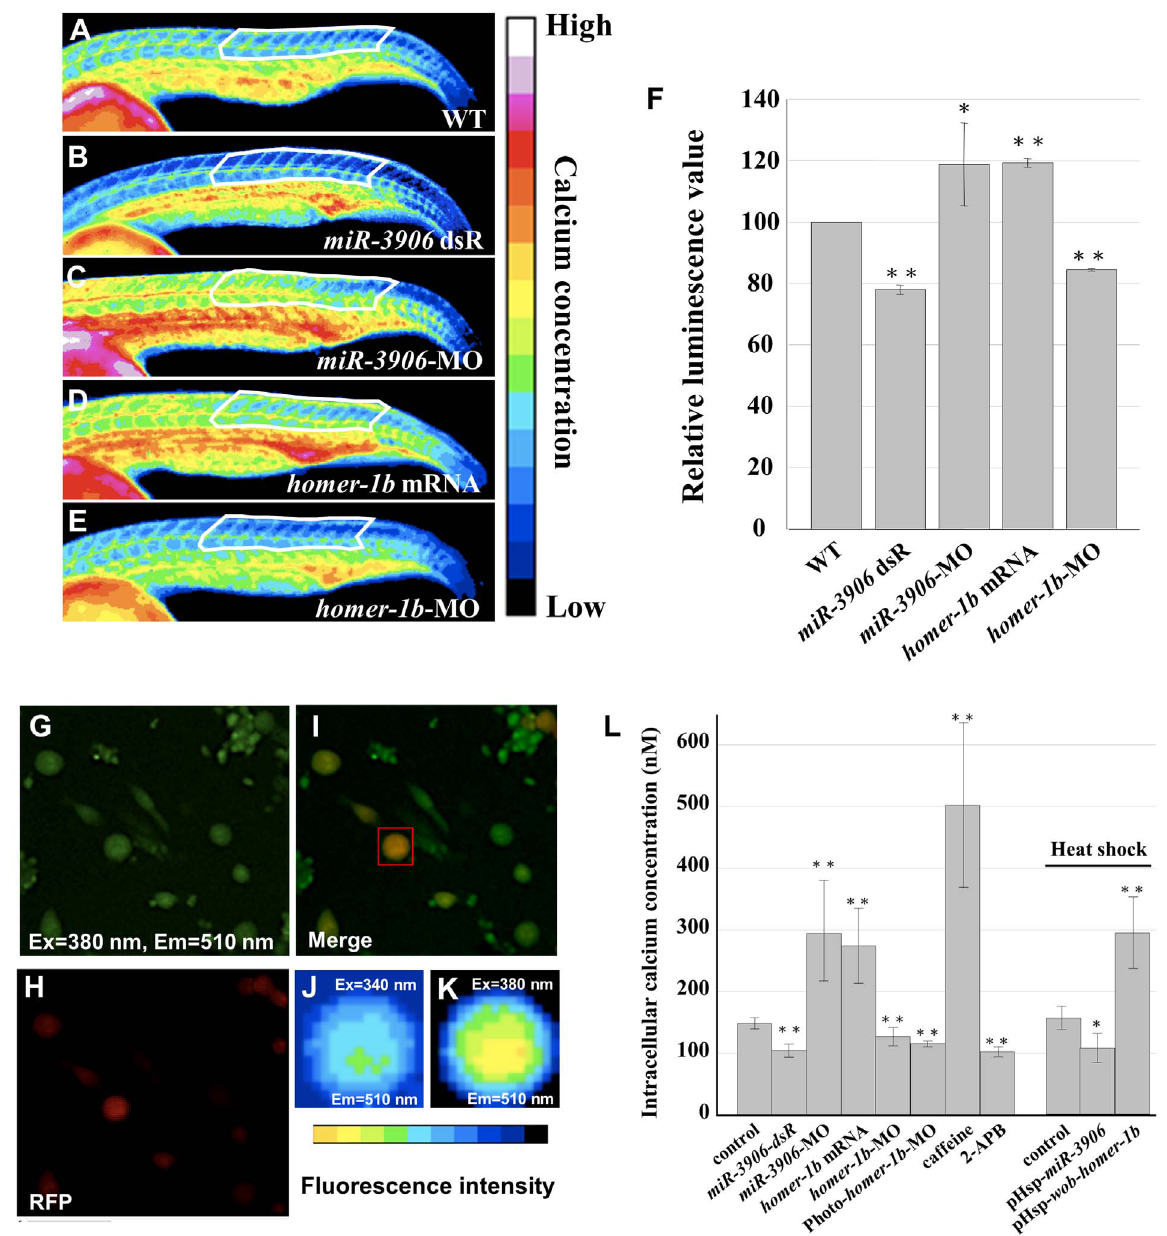
Figure 5. Injection of either homer1b- mRNA or miR-3906- MO increases the calcium concentration within muscle cells. ( A ) One-cell embryos were injected with buffer (A, as a control group WT), ( B ) miR-3906 dsR (1.15 ng), ( C ) miR-3906 -MO (8 ng), ( D ) homer-1b mRNA (400 pg) or ( E ) homer-1b -MO (3 ng) with calcium green-1 and tetramethylrhodamine (as an internal control). The gradient distribution of Ca 2 + concentration within the muscle cells in somites was analyzed at 24 hpf by ImageJ software analysis. There were 16 colors of signal images displaying the different intracellular Ca 2 + concentrations from low to high. We sketched a fixed region comprised of 11 to 20 trunk somites, as indicated, to calculate the readings from excitation emission (the region was indicated by white line). ( F ) After normalization, the reading from the WT group was set as 100, and the readings of miR-3906 dsR-injected, miR-3906 -MO-injected, homer-1b- mRNA-injected and homer-1b- MO-injected groups were compared. ( G ) The primary culture cells were stained with Fura2-AM, excited with 380 nm light, with emission at 510 nm. ( H ) The primary culture cells which displayed red fluorescence were the fast muscle cells. ( I ) The merge picture of F and G. Cells which had overlapping signals denoted in yellow were selected as detection samples (indicated by red box). ( J ) The image of fluorescence intensity shown on fast muscle cells that were excited by 340 nm, with emission at 510 nm. ( K ) The image of fluorescence intensity shown on fast muscle cells that were excited by 380 nm, with emission at 510 nm. ( L ) The value of [Ca 2 + ] i was calculated by following the formula established by Grynkiewicz et al . [31] (see Materials and Methods). The values of [Ca 2 + ] i were obtained from cells derived from WT, miR-3906 dsR-injected, miR-3906 -MO-injected, homer-1b -mRNA-injected, homer-1b -MO-injected, Photo- homer-1b -MO-injected, caffeine-soaked and 2-APB-soaked embryos, followed by heat-shocked WT, pHsp- miR-3906 -injected and pHsp- wob-homer-1b - injected embryos. SigmaPlot software was used to perform Student’s t -test. *: indicates the difference at P , 0.05 level; **: indicates the difference at P , 0.01 level. Ex: excitation; Em: emission.